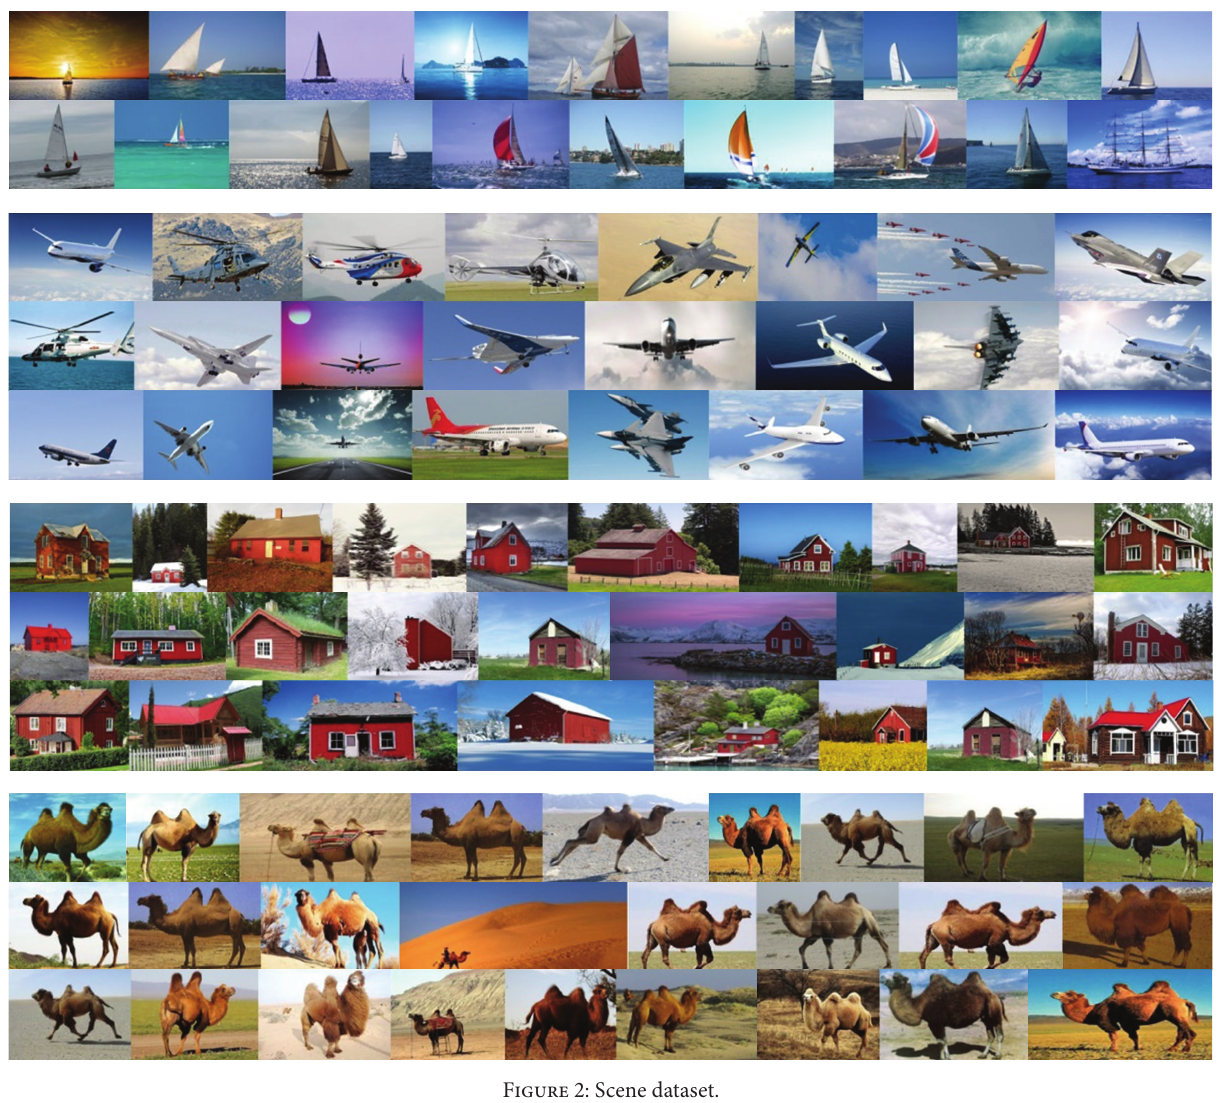
Figure 2: Scene dataset.